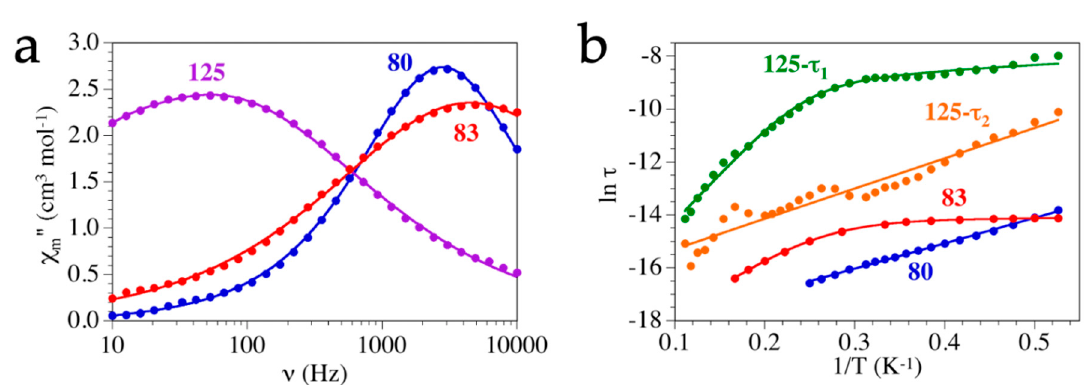
Figure 22. ( a ) Frequency dependence of χ m ” for compounds 80 , 83 and 125 at 1.9 K with a DC field of 1000 Oe. Solid lines are the fit to the Debye model with one (in 80 and 83 ) or two (in 125 ) relaxation processes. ( b ) Arrhenius plot with the relaxation time for compounds 80 , 83 and 125 with a DC field of 1000 Oe. Solid lines are the fit to the general model with Orbach mechanism in 80 and the fast process ( τ 2 ) in 125 ; Orbach and direct mechanisms in the slow process ( τ 1 ) in 125 and Orbach, direct and quantum tunnelling in 83